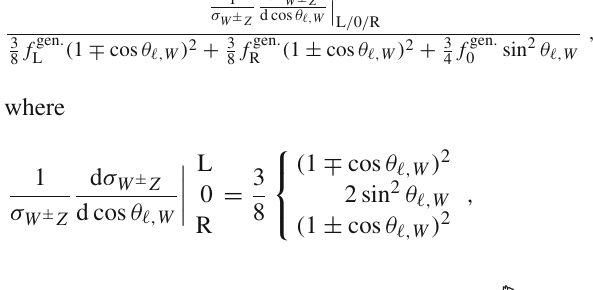
profile-likelihood fit [101] of templates of the three helicity states to the q (cid:4) · cos θ (cid:4), W and cos θ (cid:4), Z distributions. The equa- tion f 0 + f R + f L = 1 is used to constrain the independent parameters of the fit to f 0 , f L − f R and the integrated fidu- cial cross section. The templates of q (cid:4) · cos θ (cid:4), W and cos θ (cid:4), Z distributions for each of the three helicity states of the W and ple [19]. For each of the gauge bosons, generically denoted and y V by MC events are determined as a function of p V T fitting the analytic functions of Eqs. (1) and (2) to the pre- dicted cos θ (cid:4), V distributions in the total phase space. Two and y V are used. The dimensional bins as a function of p V T bin boundaries are optimised such that possible bias on the evolution of the extracted helicity fractions is